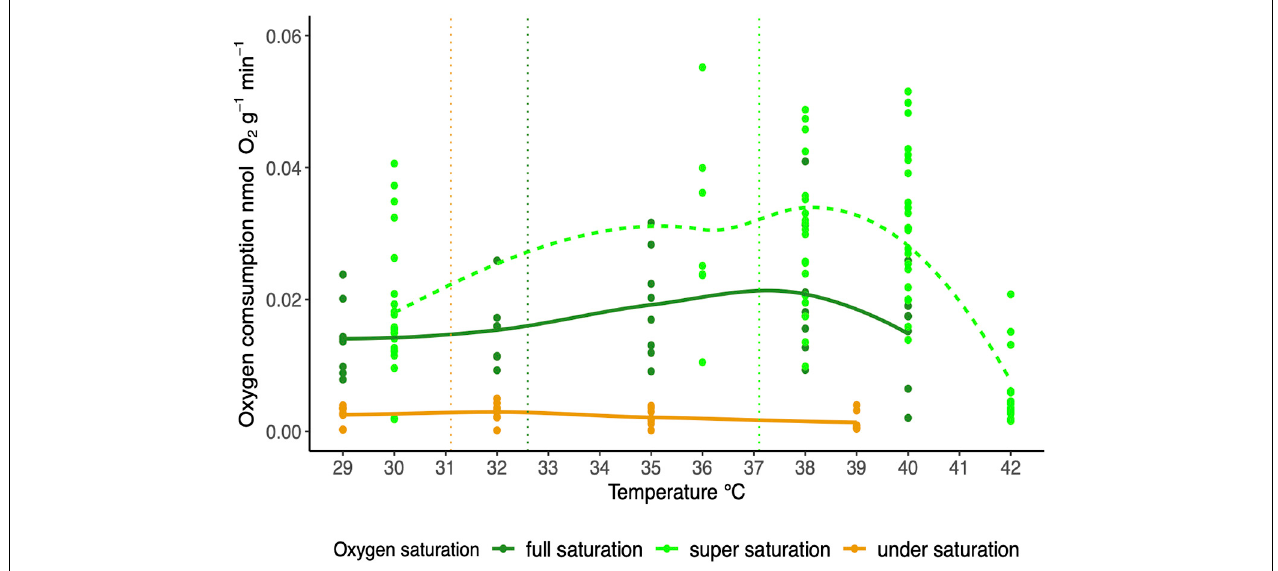
FIGURE 3 | Oxygen consumption rate of T. crenata along a temperature ramp under different conditions of water oxygen saturation: super saturation [140%, dash line: data from Giomi et al. (2019), n = 23], full saturation (100%; solid line, n = 8), under saturation (20%; solid line, n = 8). The vertical line refers to the average water temperature recorded in the mangrove creek (yellow), mangrove fringe (dark green) and seagrasses meadow